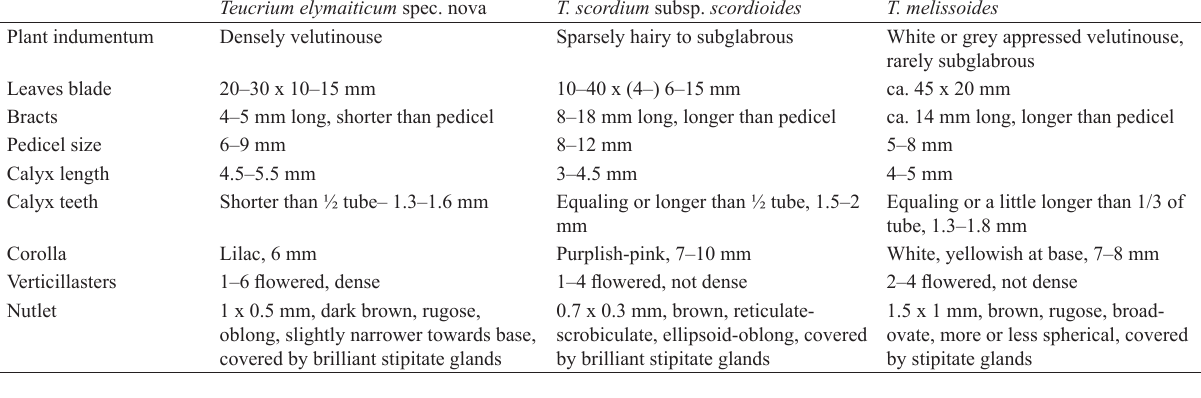
Table 1. Morphological comparison between Teucrium elymaiticum sp. nov., T. scordium subsp. scordioides and T. melissoides, from Flora Iranica (Rechinger 1982), and new observations.